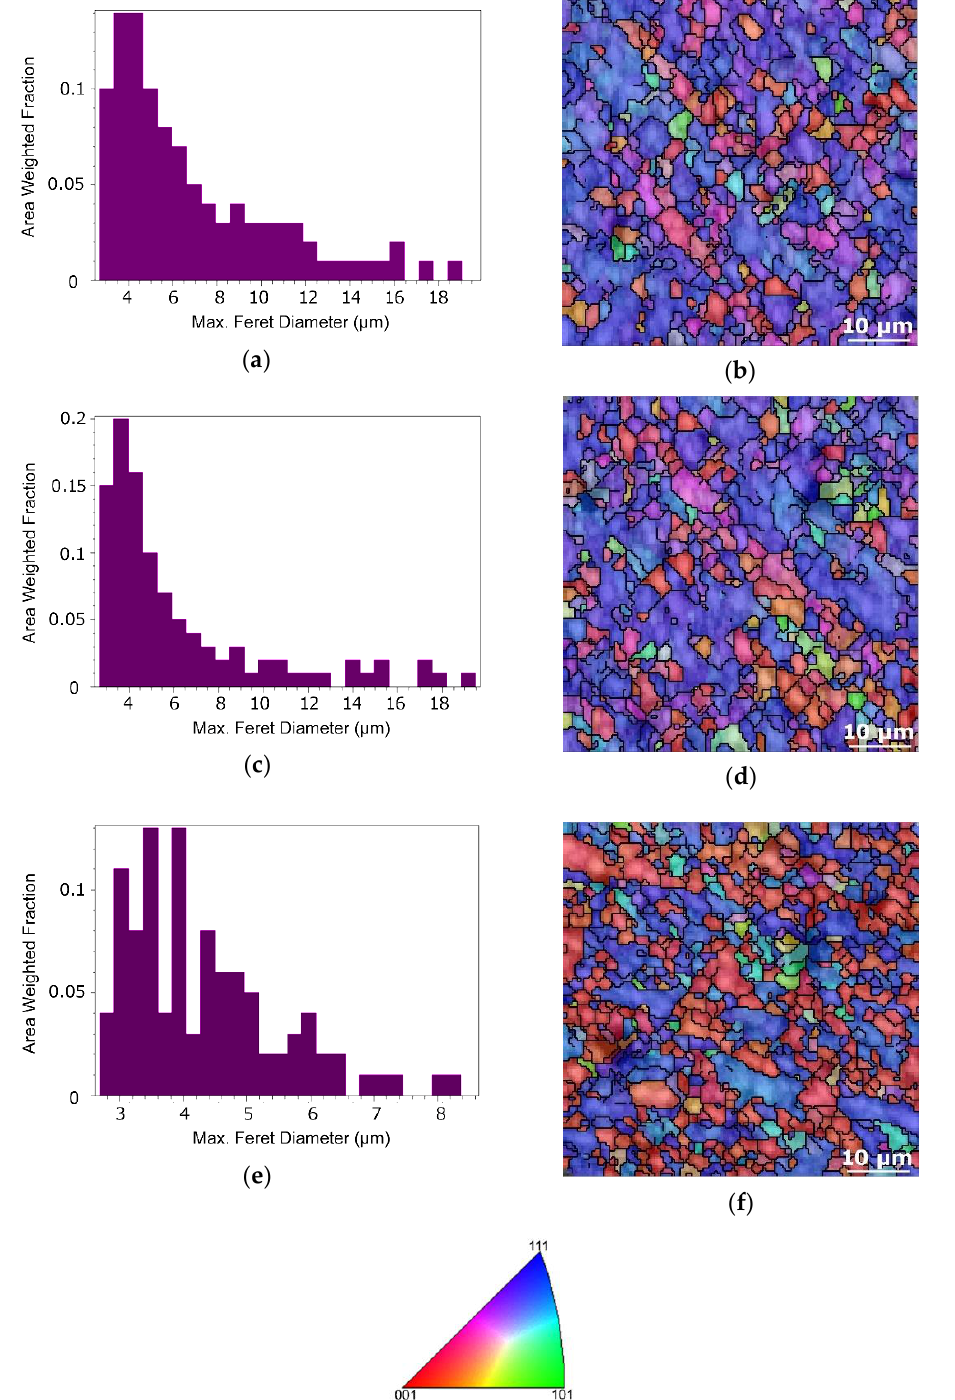
Figure 8. Results of structure analyses for: Al matrix of 20 mm composite – grain size distribution chart ( a ), orientation image map (OIM) ( b ); Al matrix of 15 mm composite – grain size distribution chart ( c ), OIM ( d ); Al matrix of 10 mm composite – grain size distribution chart ( e ), OIM ( f ).